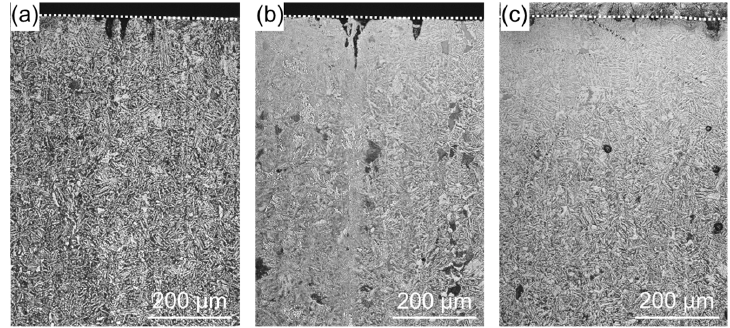
Figure 9. Cross-sectional OM images of ( a ) as-received specimen and specimens treated with ( b ) WJP